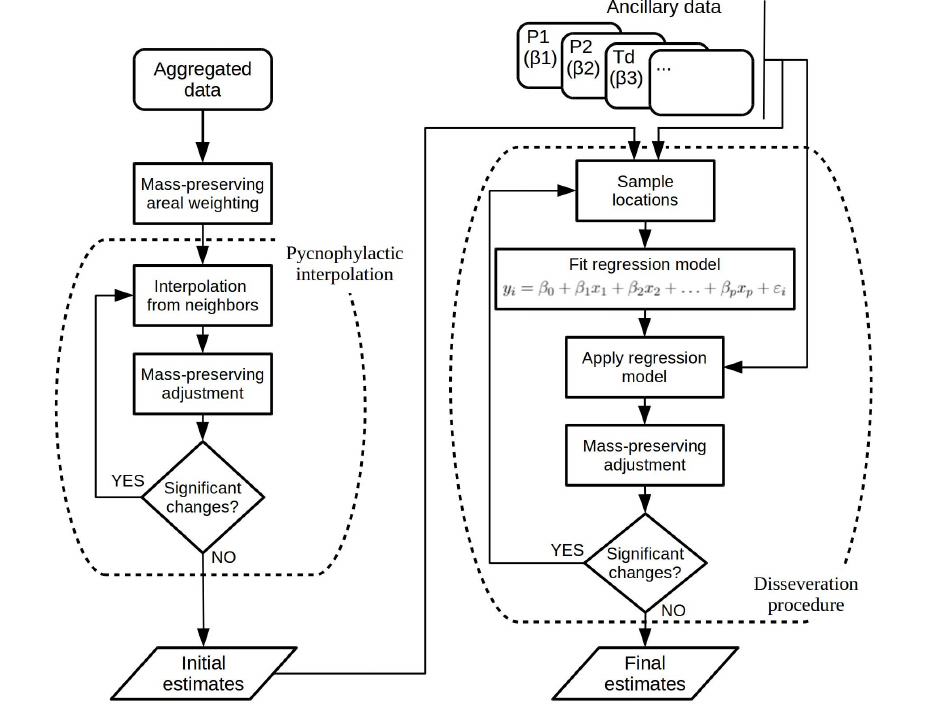
Figure 1. Different steps in the proposed hybrid disaggregation